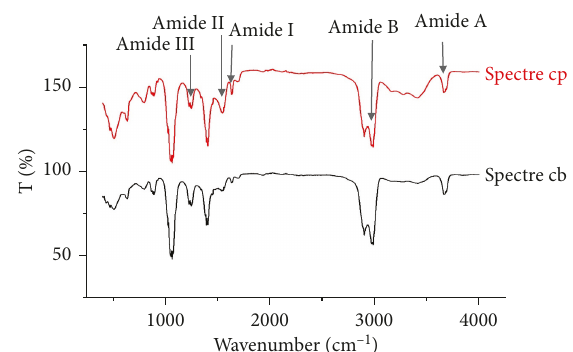
Figure 4: Fourier transform infrared spectra (FTIR) of marine collagen (CP) and bovine collagen (CB).